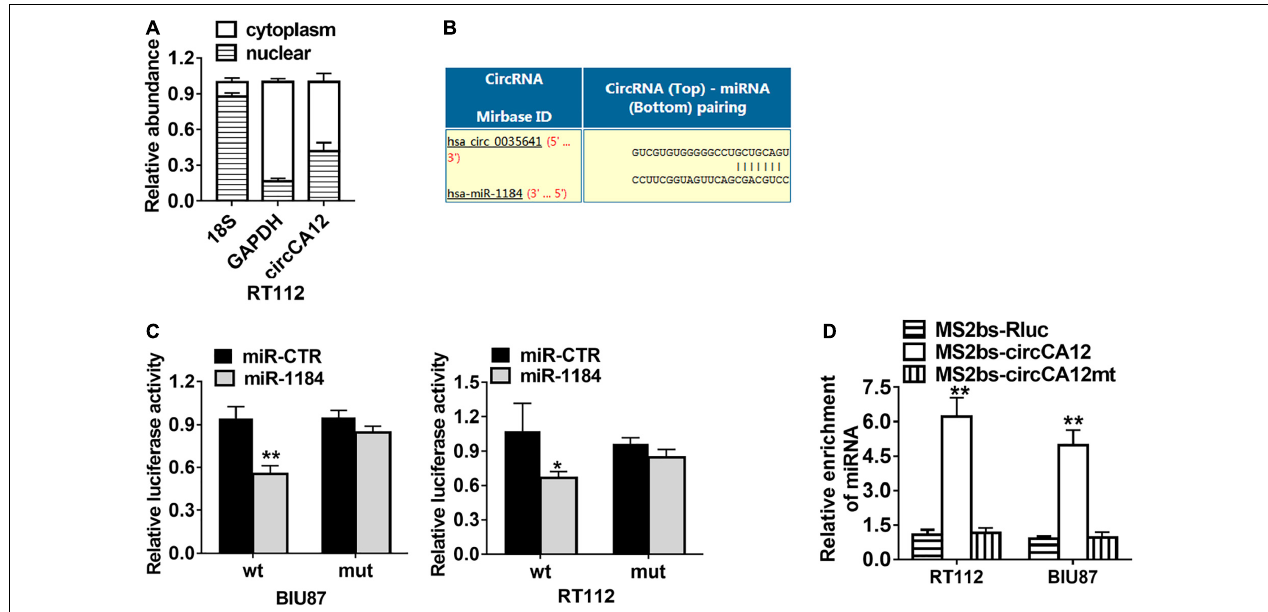
FIGURE 4 | CircCA12 serves as a sponge for miR-1184. (A) 18S, GAPDH, and circCA12 expressions levels in the cytoplasmic and nuclear fractions. (B) Prediction of the docking sites of miR-1184 in the circCA12 sequence (https://circinteractome.nia.nih.gov). (C) Luciferase reporter assay results. RT-112 and BIU-87 cells were transfected with miR-1184 mimics, accompanied by wild-type or mutant-type circCA12 luciferase reporter assay. The predicted miR-1184 binding sites of circCA12 was mutated. (D) MS2-based RIP assay in RT-112 and BIU-87 cells inserted with MS2bs-circCA12, MS2bs-circCA12-mt, or MS2bs-Rluc via transfection. * P < 0.05, ** P <